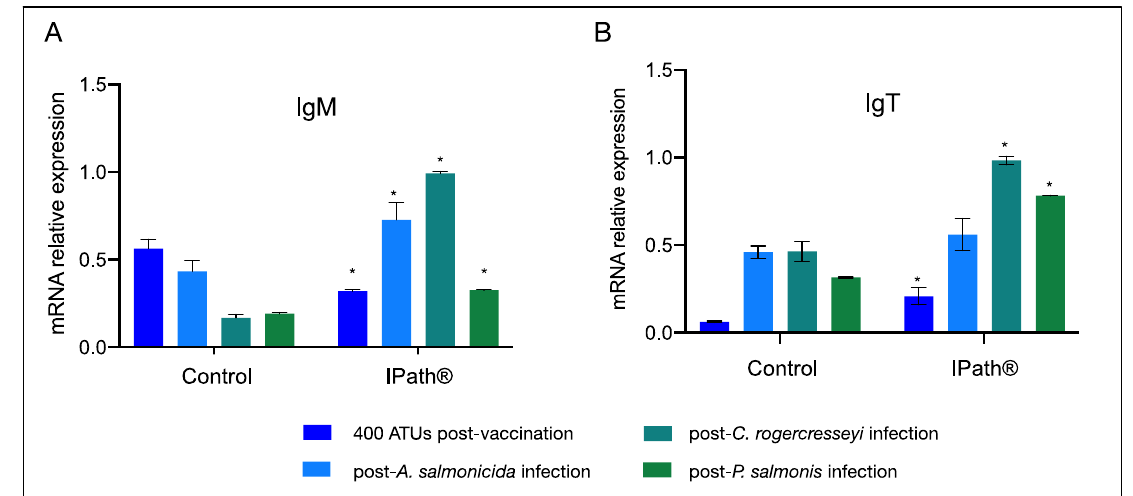
Figure 3. RT-qPCR of ( A ) IgM and ( B ) IgT of blood cells of Atlantic salmon injected with IPath ® and control group. * Indicates significant differences between IPath ® -vaccinated Atlantic salmon and the control group ( p < 0.005).